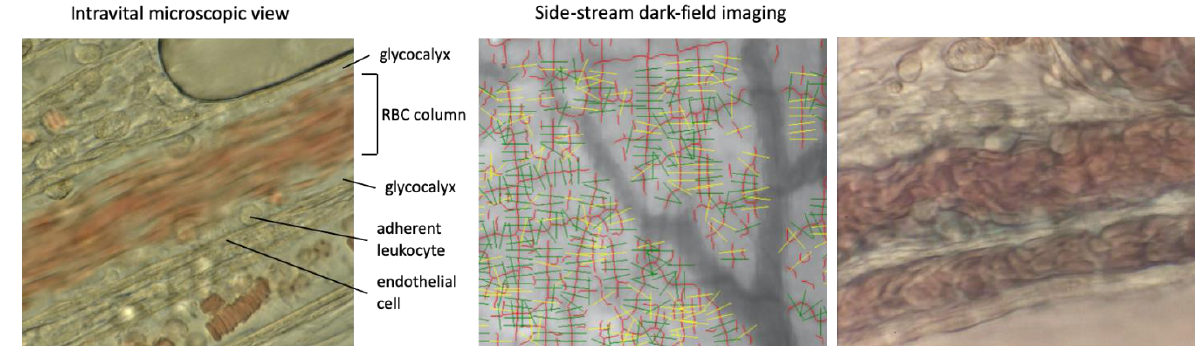
Figure 1. View of microvessels using intravital microscopy and image acquisition using the GlycoCheck™ System . Upper left: At baseline, the endothelium is visible as a smooth, thin layer, and the red blood cells (RBCs) are moving fluently. Some leukocytes have become stuck on the endothelium, but most of them are rolling. The glycocalyx layer is shown as a gap between the red cell column and the endothelial surface. 40× objective lens